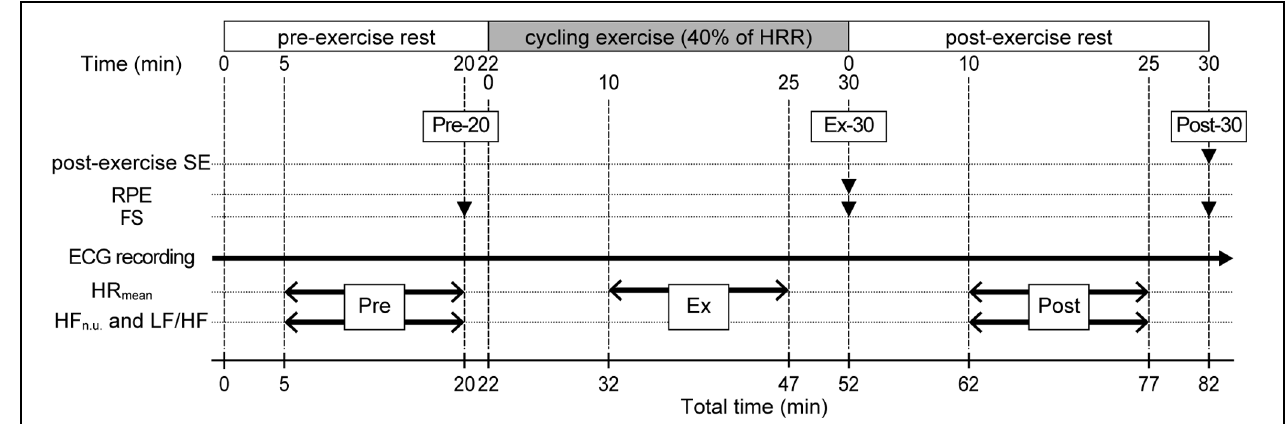
FIGURE 1 | Experimental protocol. An 82-min experimental session comprised a 22-min pre-exercise rest (Pre), a 30-min exercise (Ex), and a 30-min post-exercise rest (Post). Filled triangles indicate the time points for recording of subjective measures represented on the left. Two-headed arrows indicate the time periods for steady-state HR data represented on the left. SE, self-efficacy; RPE, rating of perceived exertion; FS, Feeling Scale; %HRR, percentage of heart rate reserve.